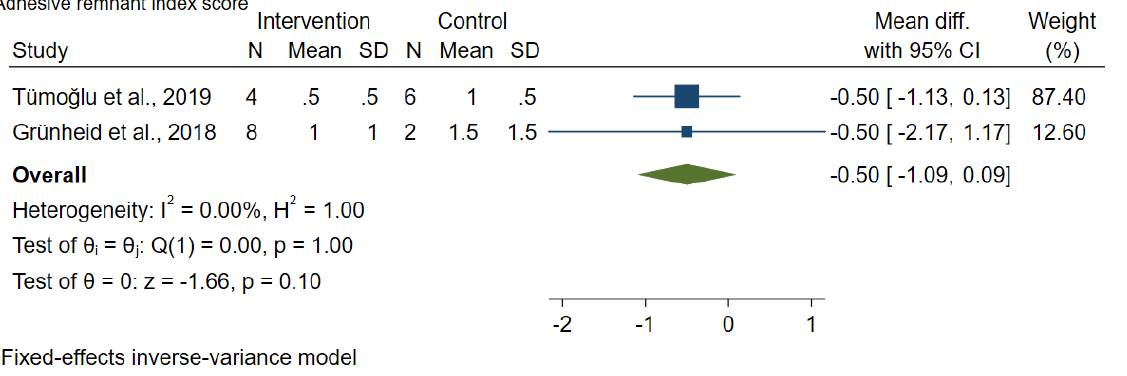
Fig. 4. Forest plot showed Mean differences of the adhesive remnant index